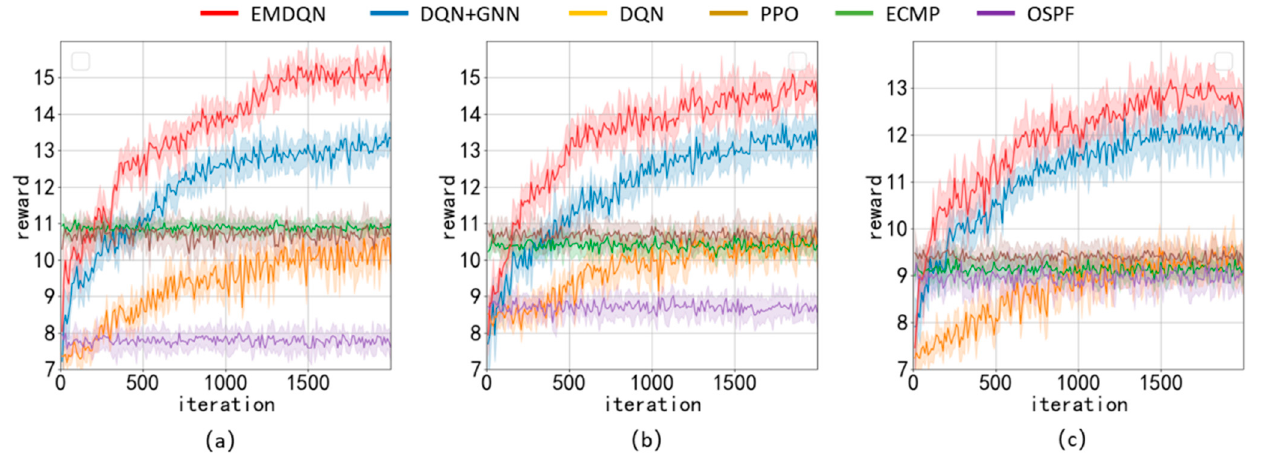
Figure 6. Comparison of the rewards of each algorithm in different scenarios: ( a ) NSFNET scenario evaluation; ( b ) GEANT2 scenario evaluation; ( c ) GBN scenario evaluation.